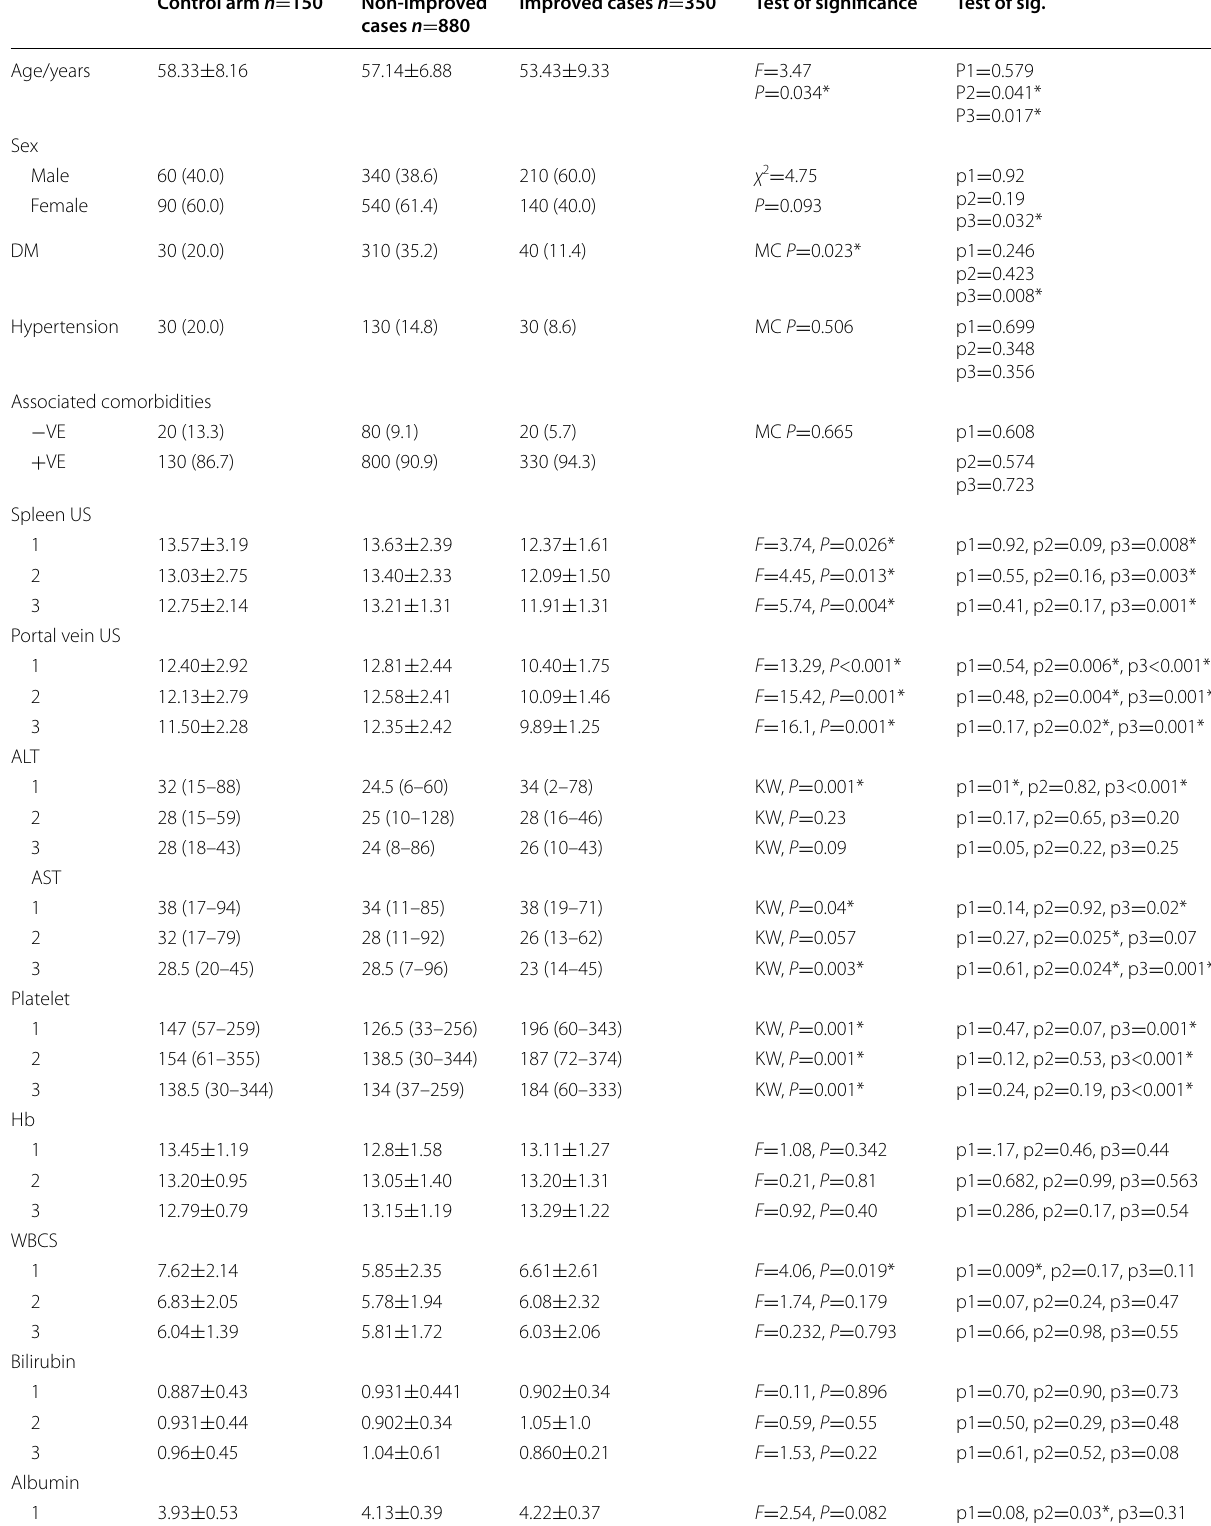
Table 4 Comparison of radiographic and laboratory results between controls, improved and non‑improved cases Control arm n 150 Non-improved Improved cases n 350 Test of significance Test of = = cases n 880 =